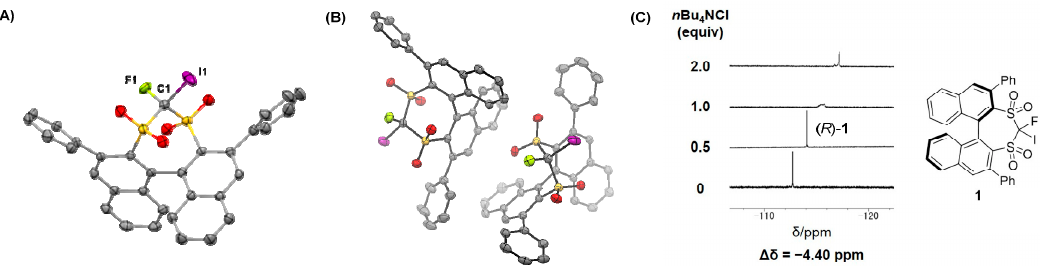
(5). ( B ) X-ray packing structure of ( R )- 1 with ellipsoid at 50% probability. The hydrogen atoms